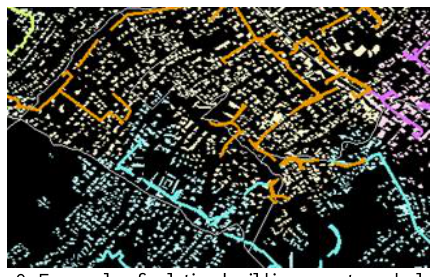
Figure 9: Example of relating building agents and electrical Figure 8: Simplified one-zone building model for electrical lines (from GIS). Building agents are geo-referenced and heating connected by proximity to the closest infrastructure line (same